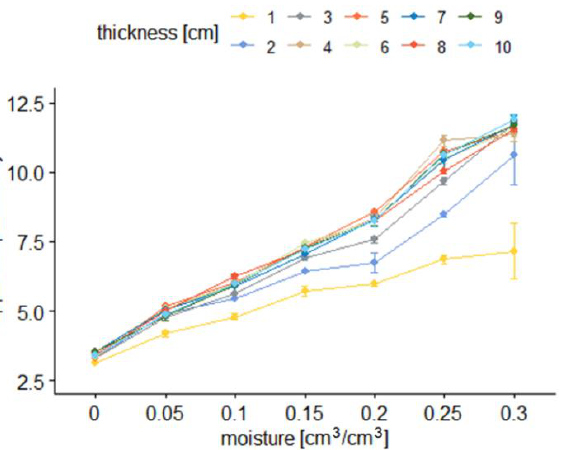
Figure 7. Average apparent permittivity readouts with sensor A depending on material moisture for particular sample thickness.